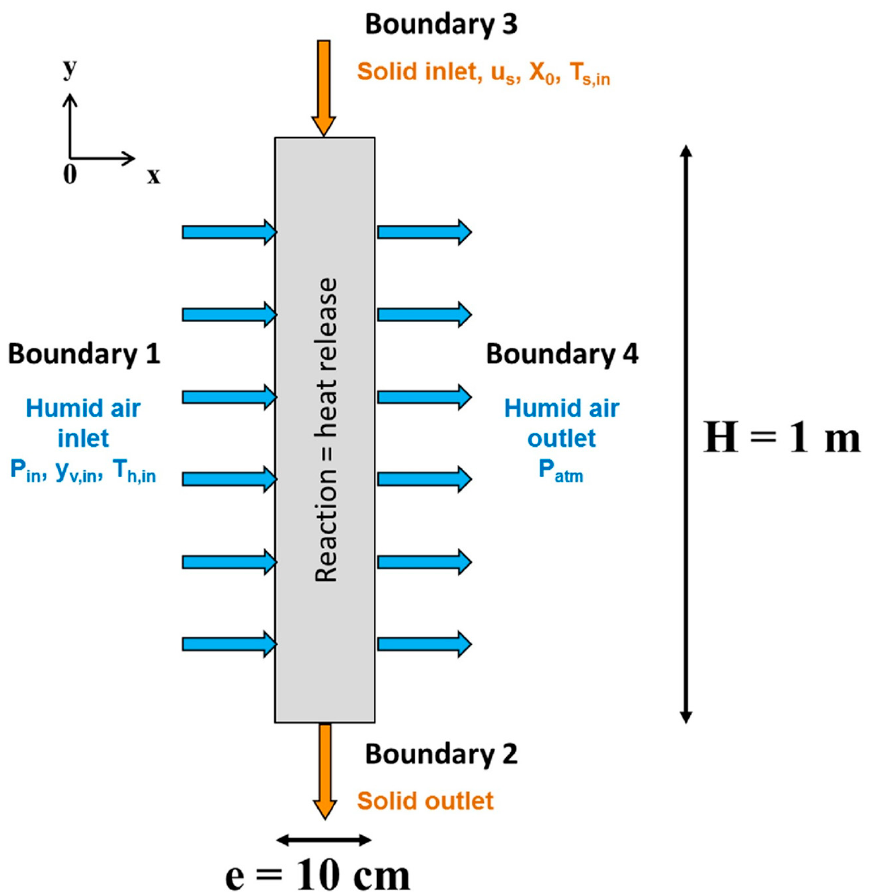
Figure 27. Geometry of the moving bed reactor in the model [265]: Reprinted with permission from Ref. [265] Copyright © 2018 Elsevier Ltd. All rights reserved.